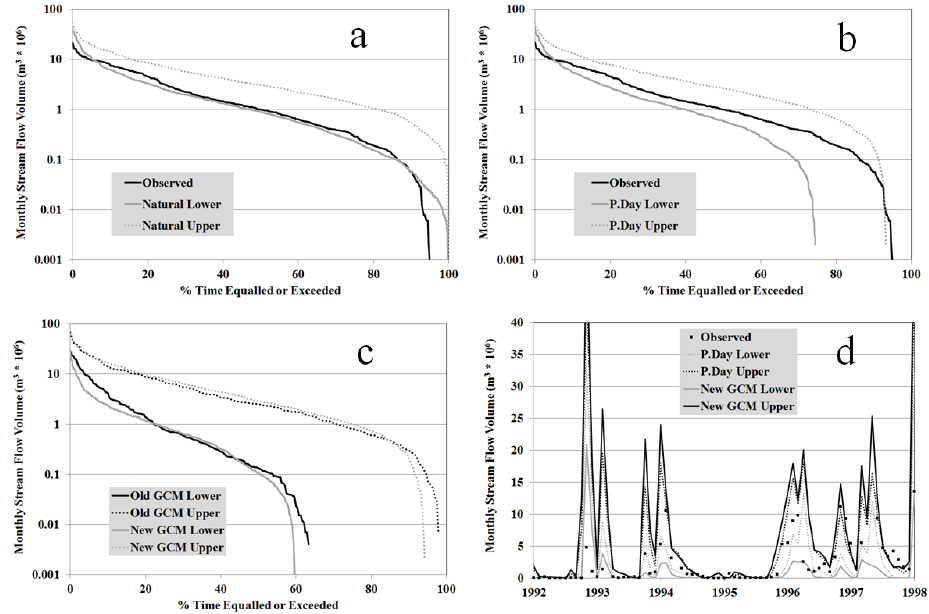
Figure 2. Upper Caledon uncertainty example. (a) Natural uncertainty bounds; (b) uncertainty bounds including present day water use; (c) near-future climate change uncertainty bounds; (d) representative time series with present day and climate change uncertainty